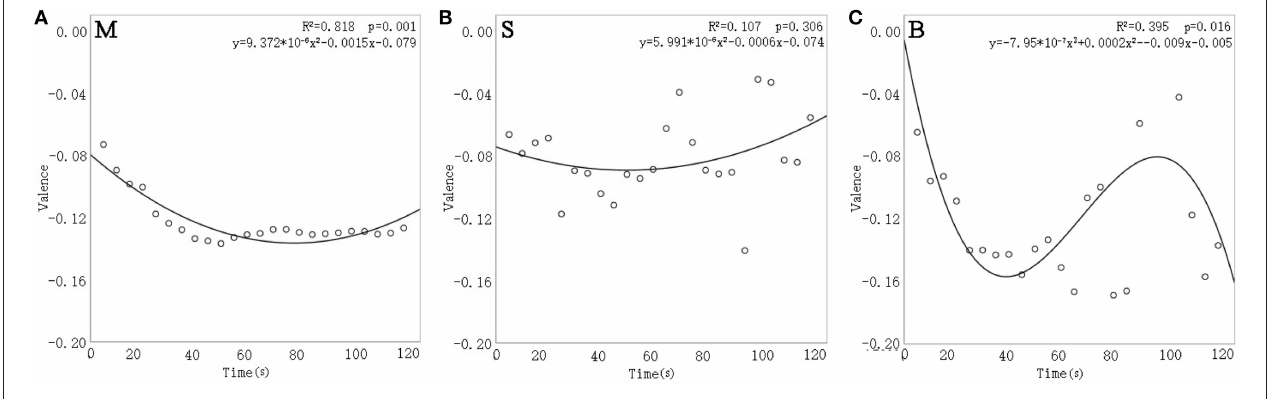
Sadness (mean = 0.036, SD = 0.015), fear (mean = 0.049, SD = 0.022), and disgust (mean = 0.042, SD = 0.021)